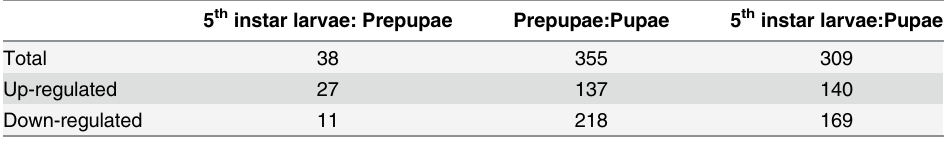
Table 3. Differentially Expressed Genes across all